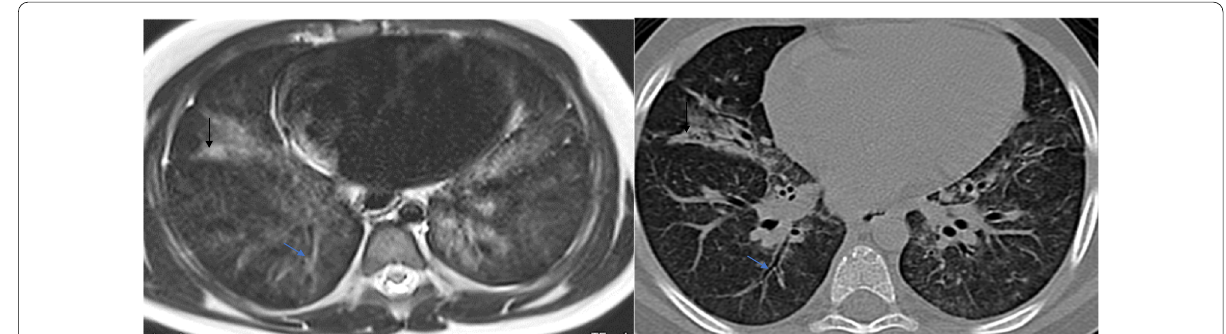
Fig. 2 Male child with history of chronic aspiration due to esophageal dysmotility, T2 HASTE, and comparable HRCT cut; both show the score 1 bronchiectasis and bronchial wall thickening, score 2 bronchial generation (blue arrows), mucoid impaction (black arrows), ground-glass densities and centrilobular nodules, more delineated in HRCT (arrowhead). CT score 14, MRI score 10